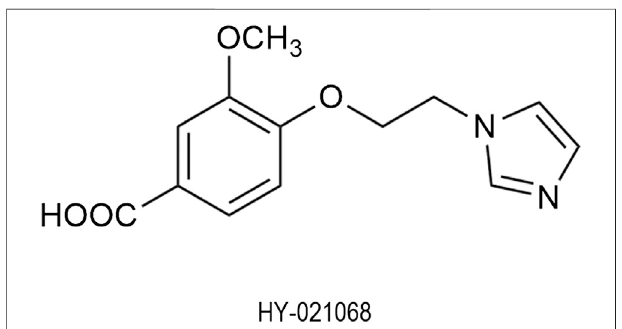
FIGURE 1 | Chemical structure of